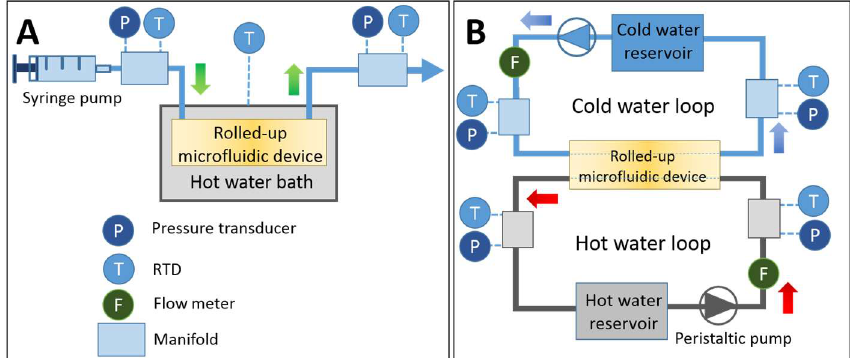
Figure 2. Illustration of the experimental setup. ( A ) The setup for the single-channel device consisted of one syringe pump to inject DI water into the device whilst the device was immersed in the warm water bath. While running through the rolled-up device, the running DI water harvested the heat flux from the hot water bath at varied flow rates, resulting in increasing temperature at the outlet. ( B ) The setup for dual channel device contains two loops of fluids i.e., hot water stream and cold water stream. Each loop had a peristaltic pump and water bath to set the flow rates and temperatures. The inlet and outlet temperatures were measured by using resistance temperature detector (RTD) probes and pressures were measured by pressure transducers, both of which were connected to a data acquisition system (DAQ).